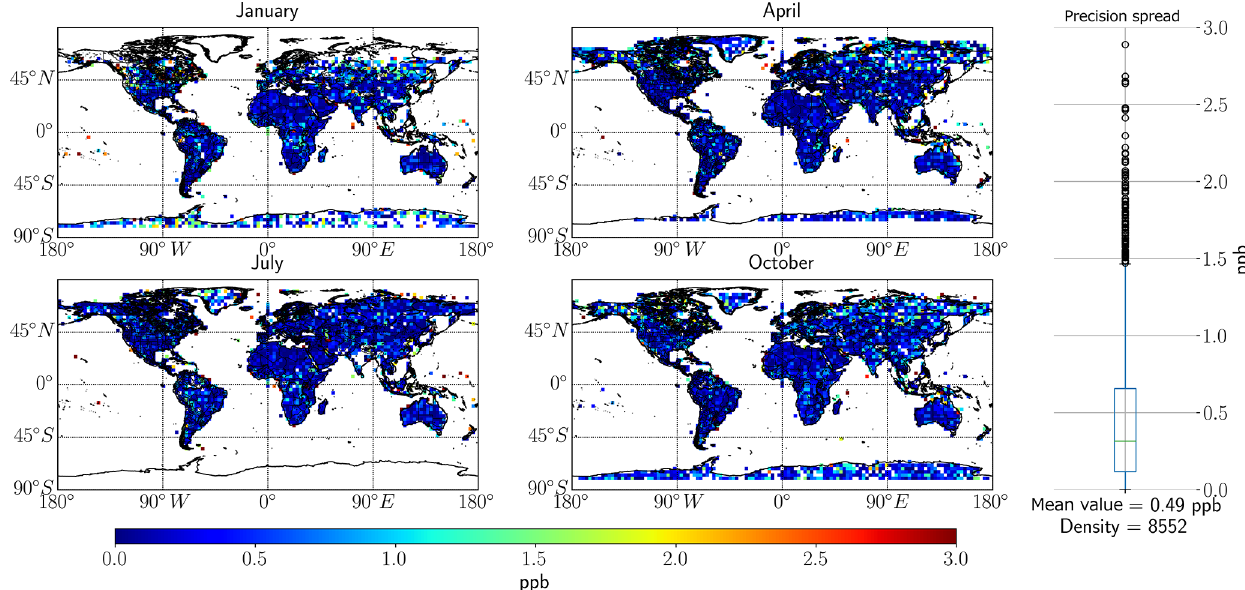
Figure A3. As Fig. A1 but focused on dual-band